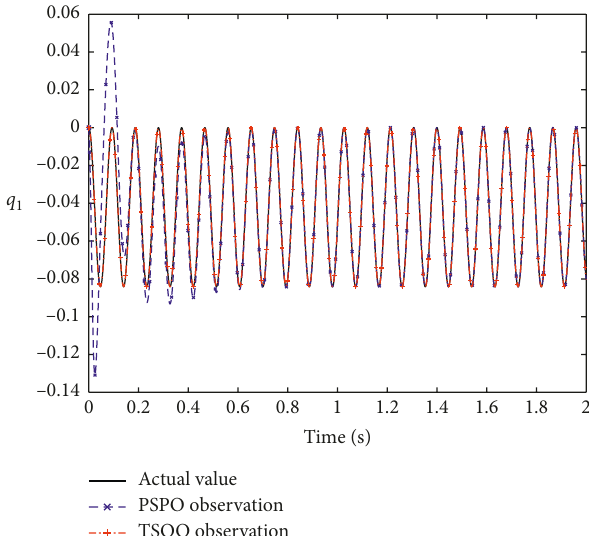
Figure 5: Observation effect comparison for the displacement of the first-order mode coordinate.